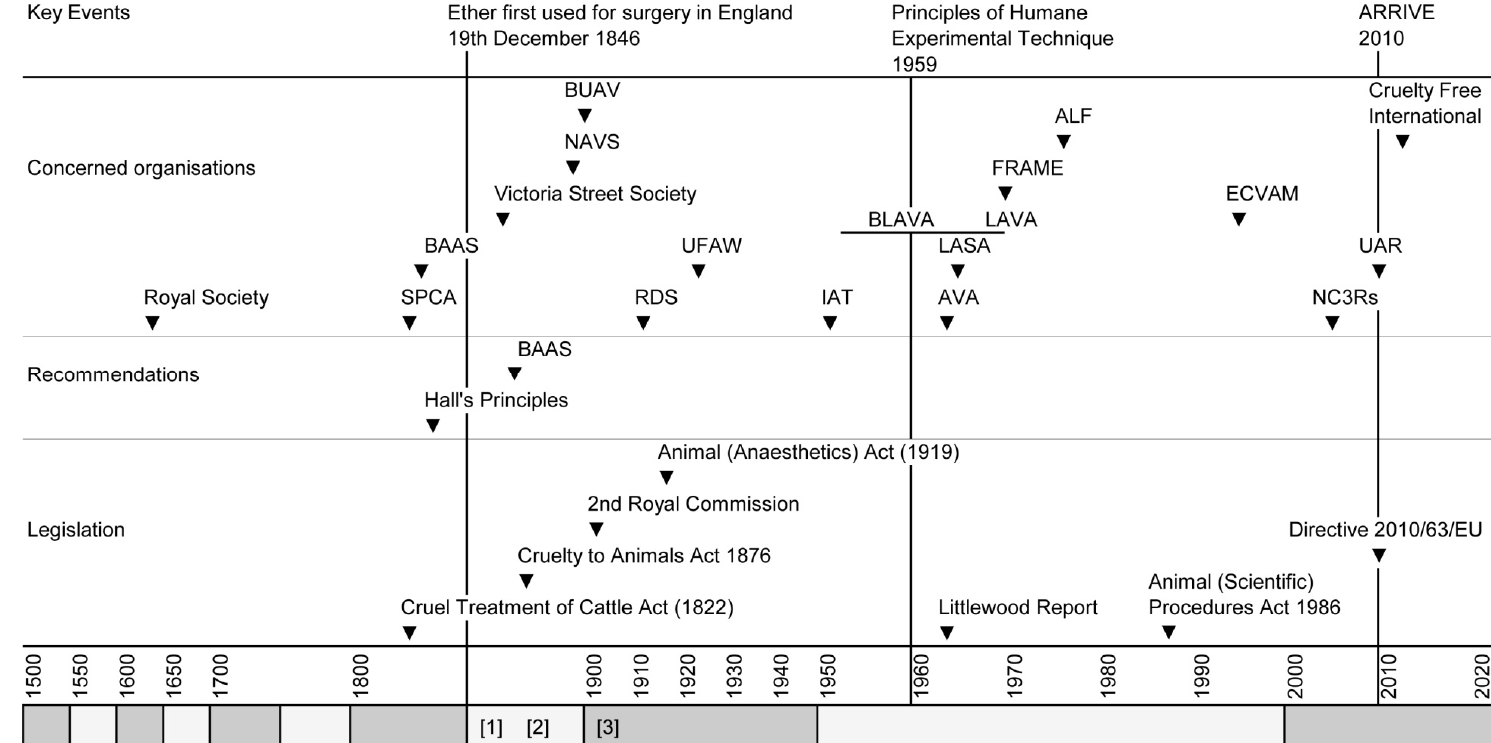
Figure 2. Key events in animal experimentation in the UK partitioned into the introduction of legislative and optional (recommended) constraints, and the formation of societies that have influenced the use of anaesthetics and analgesics in animal experiments. Alternatively shaded x axis blocks each represent a 50 year epoc. A(SP)A 1986: The Animals (Scientific Procedures) Act 1986. ARRIVE: Animals in Research: Reporting in Vivo Experiments; Reporting guidelines. Additional dates